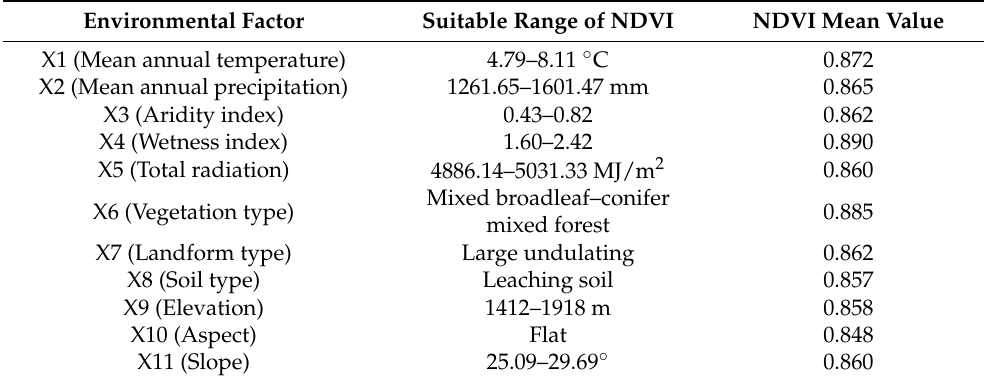
Table 4. Suitable range of environmental factors for NDVI. (Confidence level